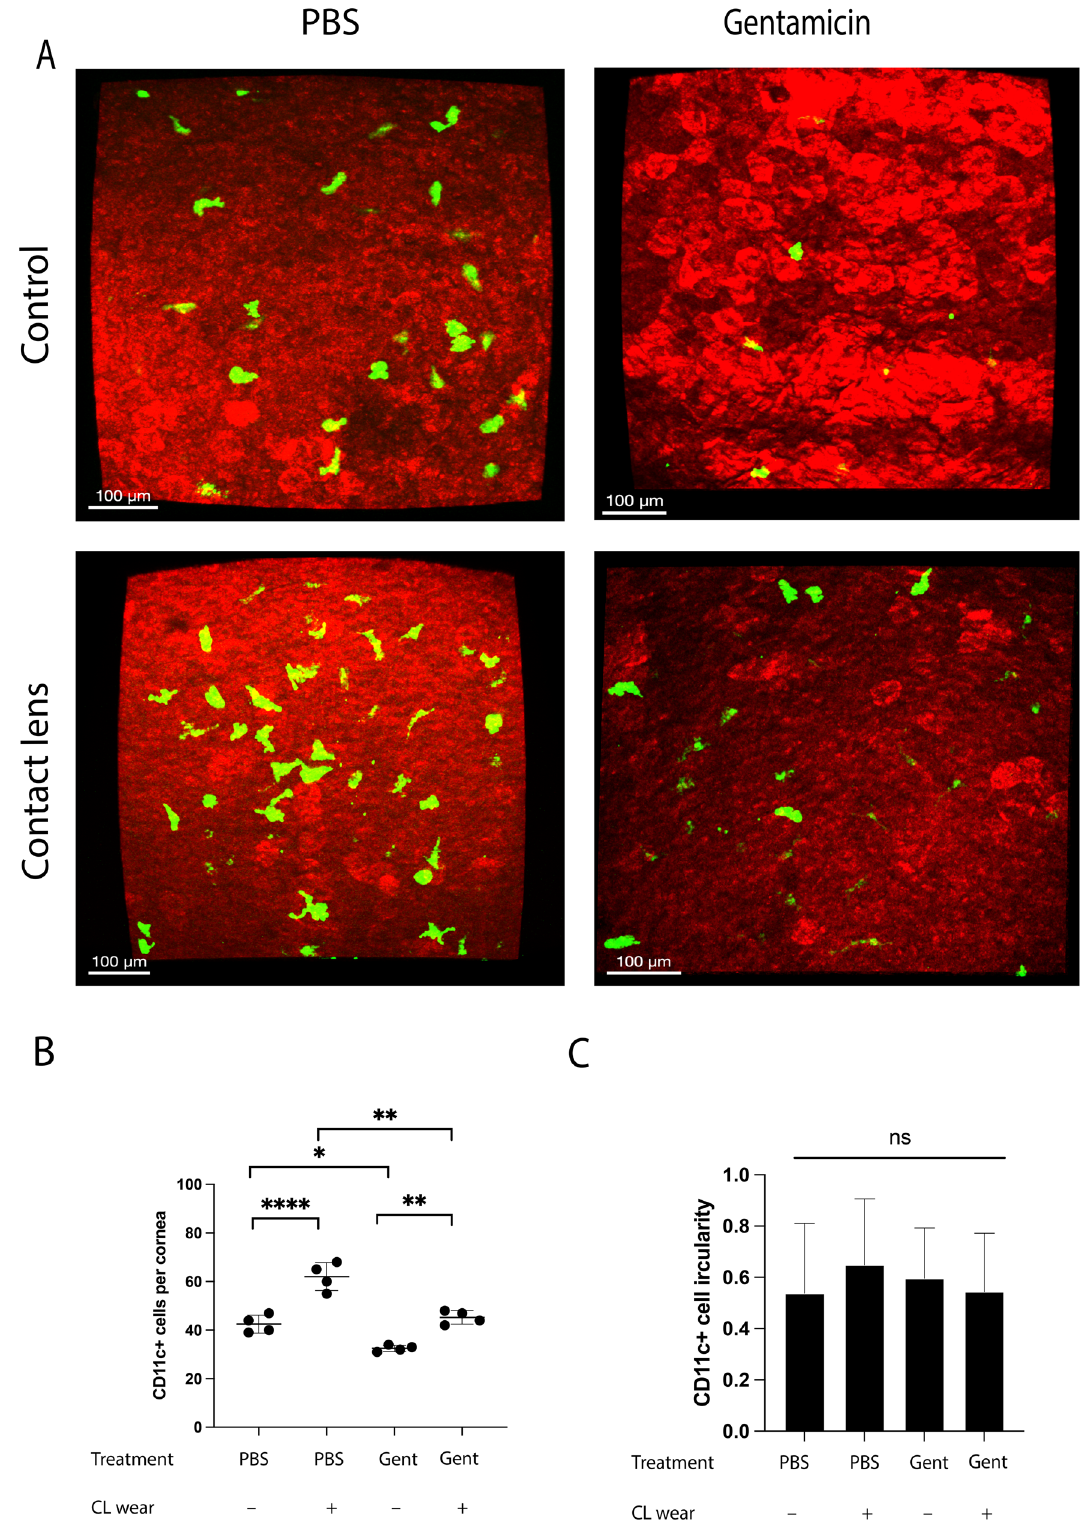
Figure 2. Gentamicin treatment did not prevent the 24 h CD11c+ cell response to contact lens wear. ( A ) Maximum intensity z-projection of the YFP signal from CD11c+ cells in the central cornea after 24 h of contact lens (CL) wear versus non-lens wearing contralateral controls with PBS or gentamicin treatment. ( B ) Quantification of the CD11c+ cell responses after 24 h. Lens-associated CD11c+ cell responses were evident in each instance. Scale bar = 100 µm (*P < 0.05, **P = 0.002, ****P < 0.0001; One-way ANOVA with Tukey’s multiple comparisons test). ( C ) Quantification of morphological parameters (circularity) of CD11c+ cells from the same experiment. There was no significant difference between groups ( ns not significant; One-way ANOVA with Tukey’s multiple comparisons